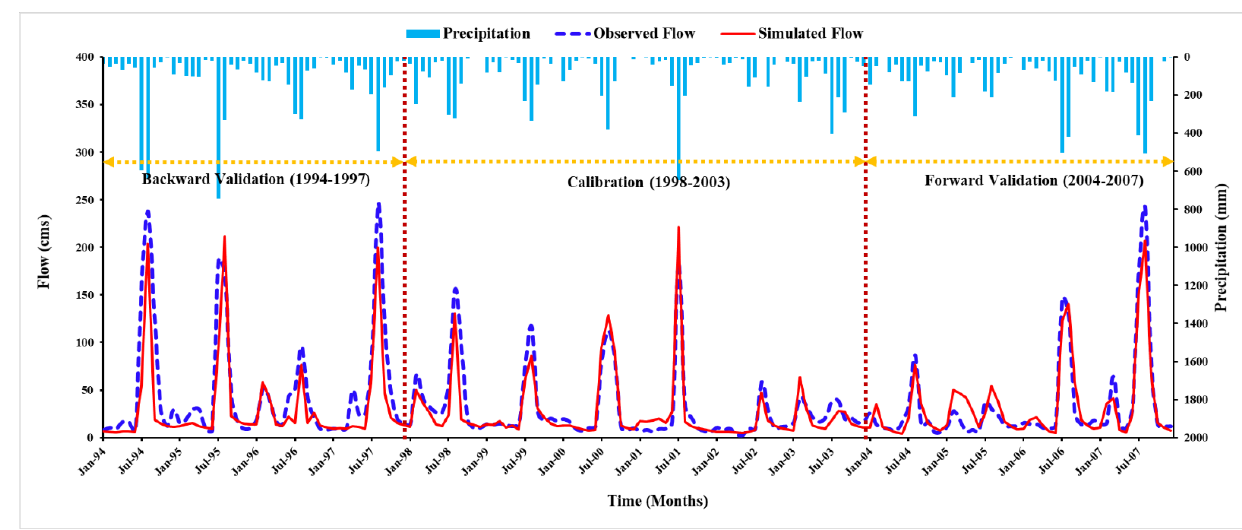
Figure 5. Calibration and validations of stream flows, Soan River Basin.